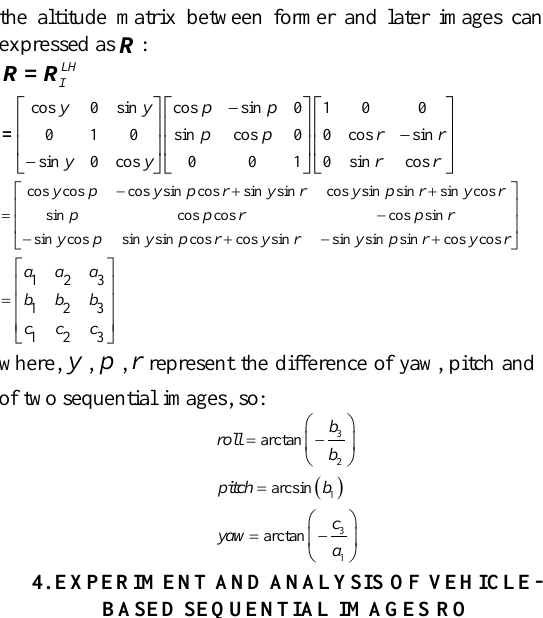
Figure2. The IMU and Camera coordinate system of LandMark MMS The coordinate axes - - X Y Z of IMU and the coordinate I I I